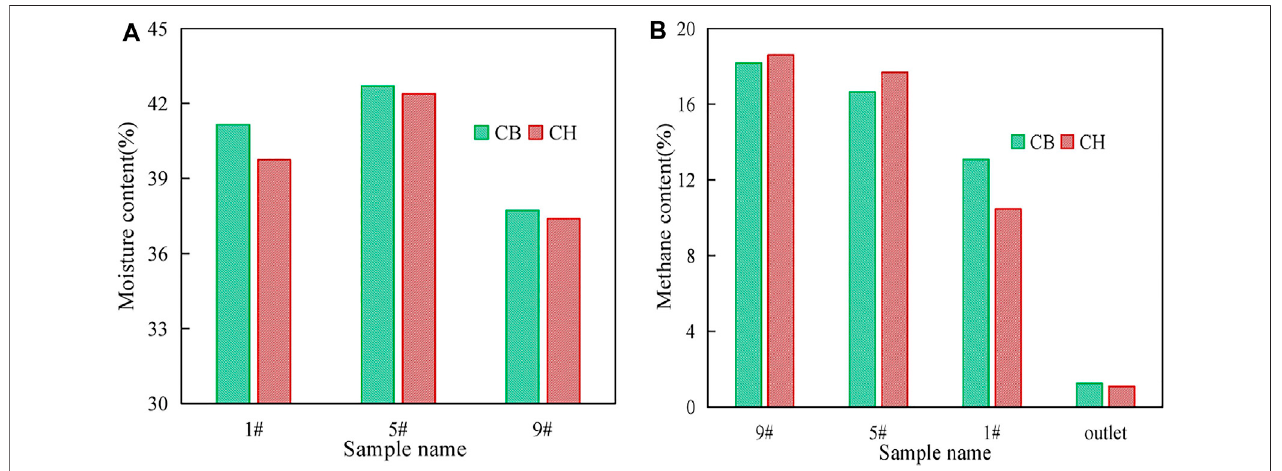
FIGURE 3 | Changes of moisture content (A) and methane content (B) in CB and CH after simulated